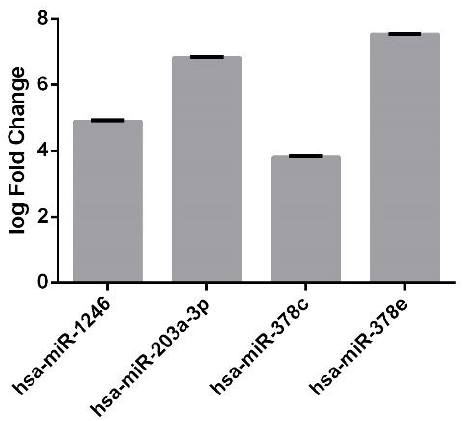
Figure 1. Venn diagram of overlapping and specific miRNAs in plasma and placenta.